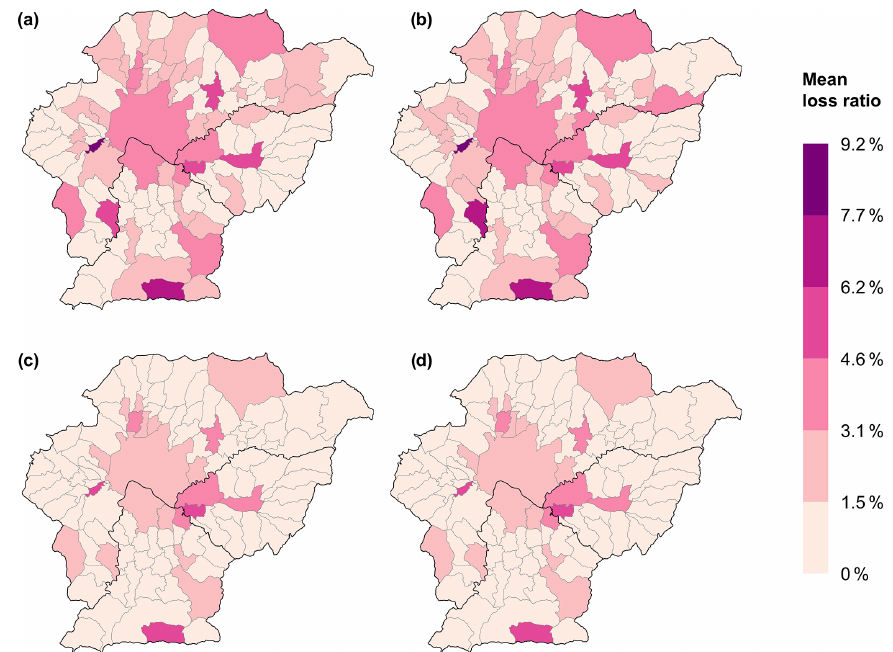
Figure 10. Spatial distribution of mean loss ratios, associated with the 100-year flooding occurrence, for (a) Scenario A, (b) Scenario B, (c) Scenario C, and (d) Scenario D.